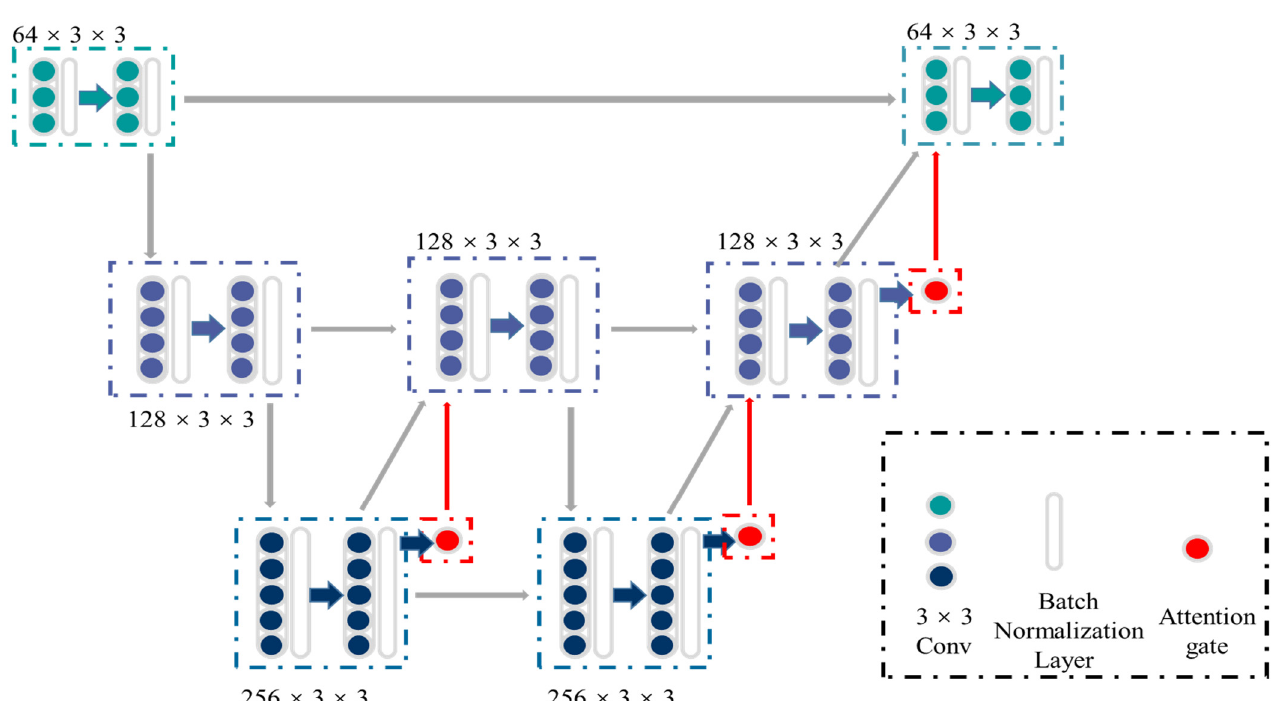
Figure 2. The structure of ASW-Net. There are three down-sampling processes (encoding phase), three up-sampling processes (decoding phase), and three attention gates, which form the shape of a ‘W’. The green and blue dots represent the convolutional blocks, while the white transparent boxes represent the batch normalization layers and the red dots represent the attention gates. The gray, green, blue, and red arrows represent the data flow.